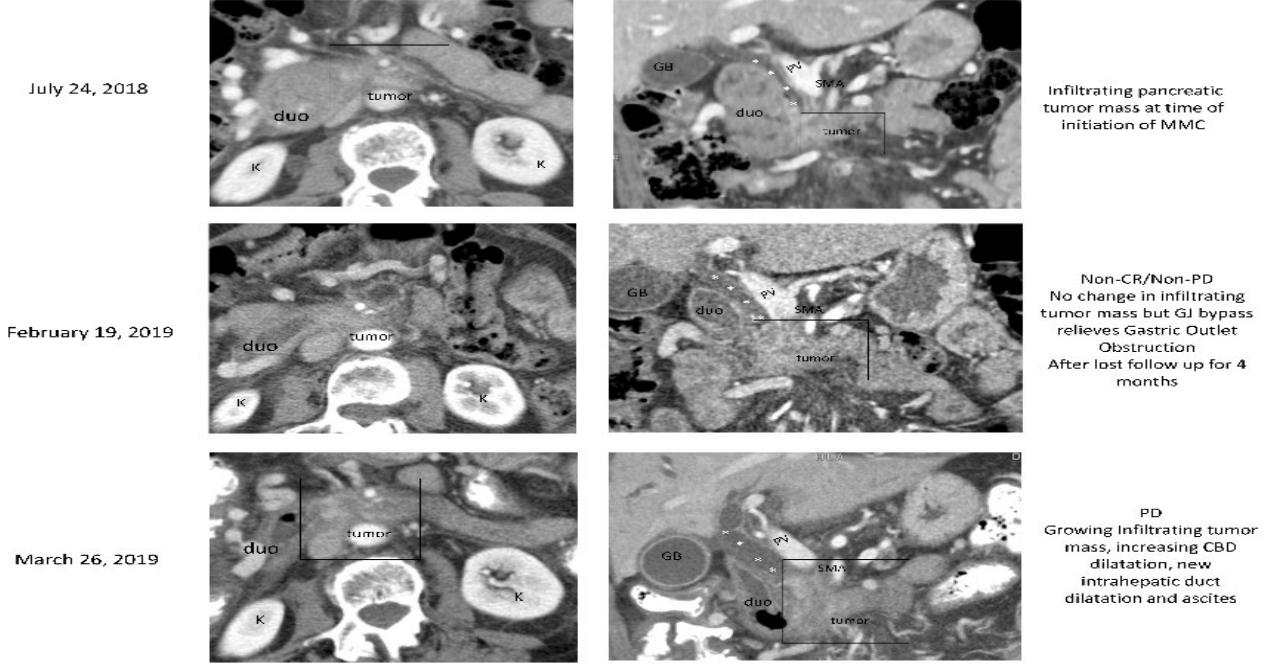
Figure 3. Case 2 treatment responses. Legend: Tumor response to Mitomcyin C from patient 2. Stable disease seen in primary pancreas mass (labelled ‘tumor’) between initiation of therapy at 24 July 2018 until 19 February 2019. Growth of primary tumor seen on 26 March 2019. Duo: duode- num, K: kidney, PV: portal vein, SMV: superior mesenteric vein, GB: gallbladder, SMA: superior mesenteric artery.